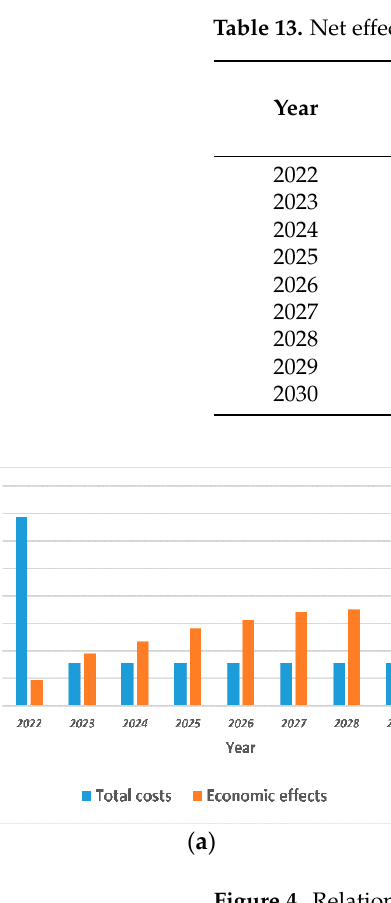
Table 13. Net effects balance projection (in EUR).